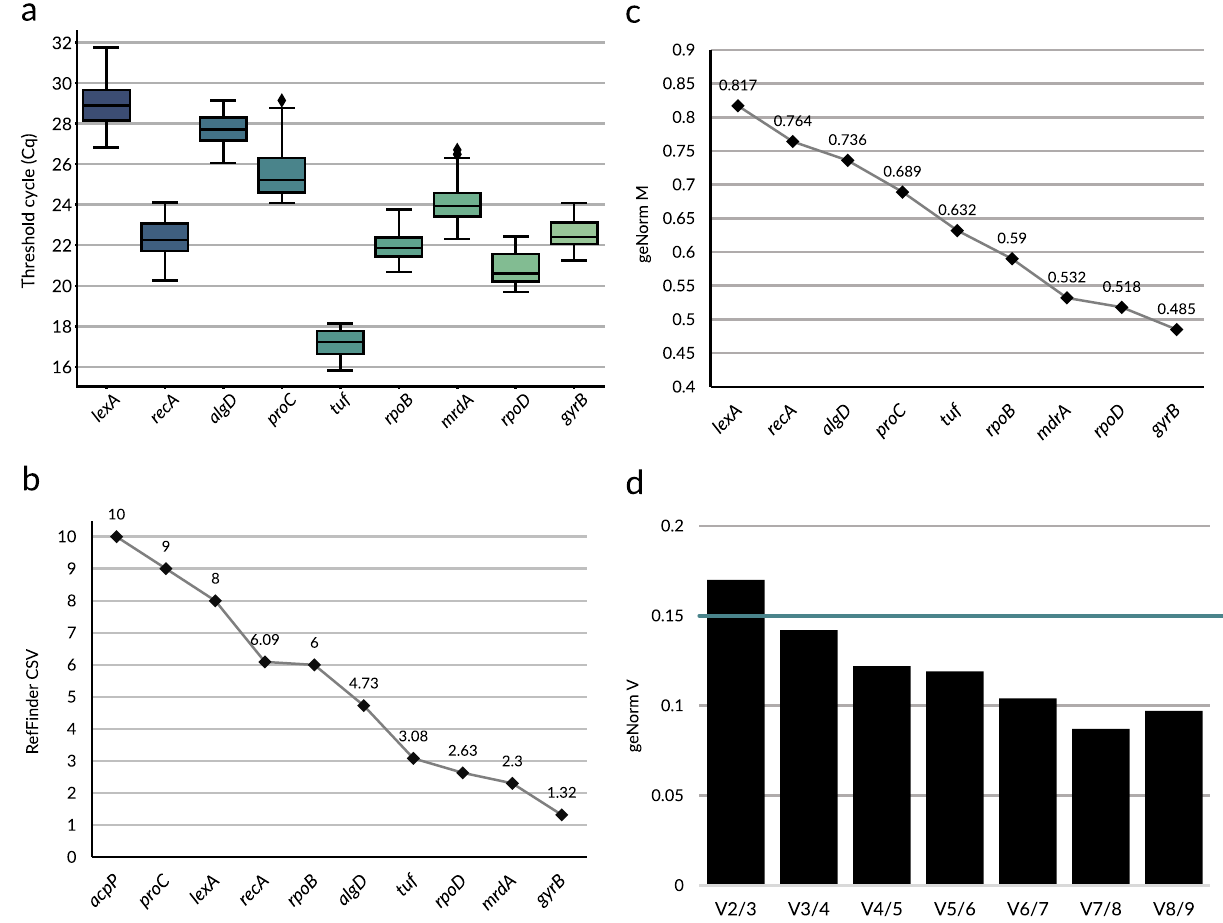
Figure 2. RT-qPCR reference gene selection for Pseudomonas donghuensis P482. ( a ) Boxplot representing the distribution of Cq (threshold cycle) data among the tested potential reference genes. The plot was calculated from raw data consisting of technical replicates’ mean Cq for each sample. The band in the box represents the median value, the top edge of the box is the upper quartile (Q3) while the bottom edge of the box is the lower quartile (Q1). Q3 and Q1 referred to the 75th percentile and the 25th percentile, respectively, meaning that 75 or 25% of the data were at or below the point. The whiskers represent the maximum and minimal values excluding outliers. Outlier data is presented with black diamond symbol ( ♦ ). ( b ) RefFinder comprehensive stability value (CSV) calculated as a geometric mean of the ranks assigned to the tested RGs by algorithms comprising RefFinder tool. The lower the CSV, the more stable the expression of a given gene. ( c ) qbase + geNorm RG stability analysis. Average expression stability of tested RGs obtained with geNorm algorithm shown as geNorm M value. The lower the M value, the more stable the gene expression. ( d ) Determination of the optimal number of reference targets shown as qbase + geNorm V chart for the tested reference targets. Analysis shows no significant difference in experimental situation when comparing the use of 3 or 4 reference genes (geNorm V < 0.15 for V3/4), meaning 3 reference genes are sufficient for expression